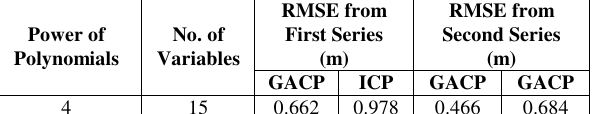
Table 8: Results of Quartic Polynomial Optimisation with GA